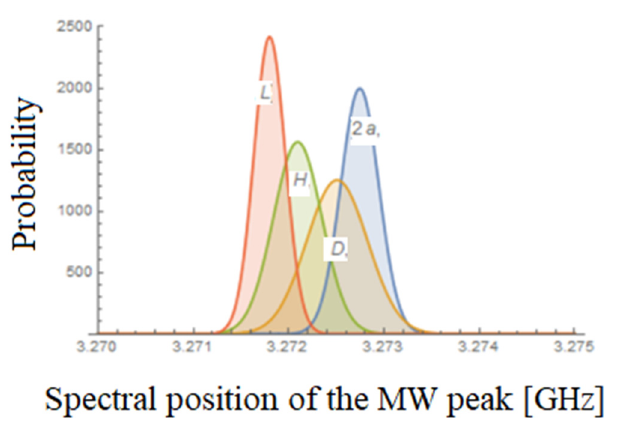
Figure 22. Spectral location of S12 peaks for different color graded diamonds (obtained after 20 re- peated measurements). Table 6. Average and STD of the spectral peaks at frequencies range 3.15–5.95 GHz for different master